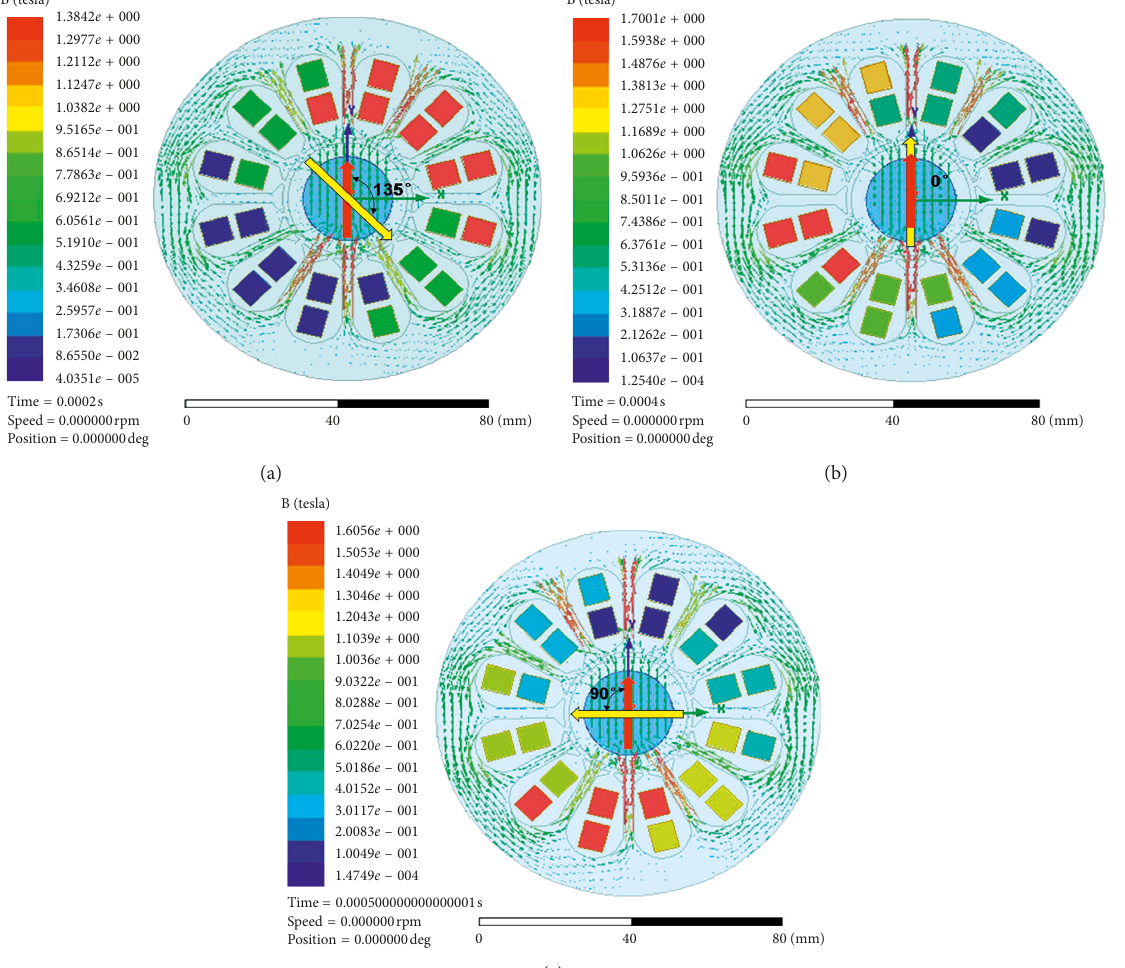
Figure 4: Flux density vector field and current vector field of the FE model. (a) Fields at 0.0002s. (b) Fields at 0.0004s. (c) Fields at 0.0005s. B (tesla) 1.5428 e + 000 1.4464 e + 000